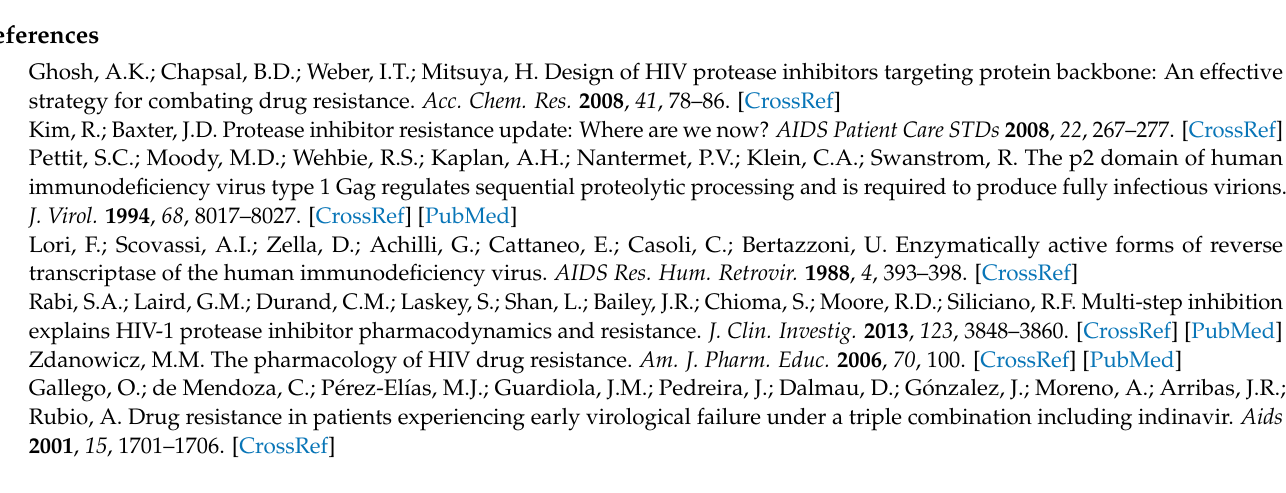
Gag-PR size 1.7 kb. Figure S2: Gel picture showing the amplification of envelope. Envelope size 3.5 kb. Table S1: Sequencing